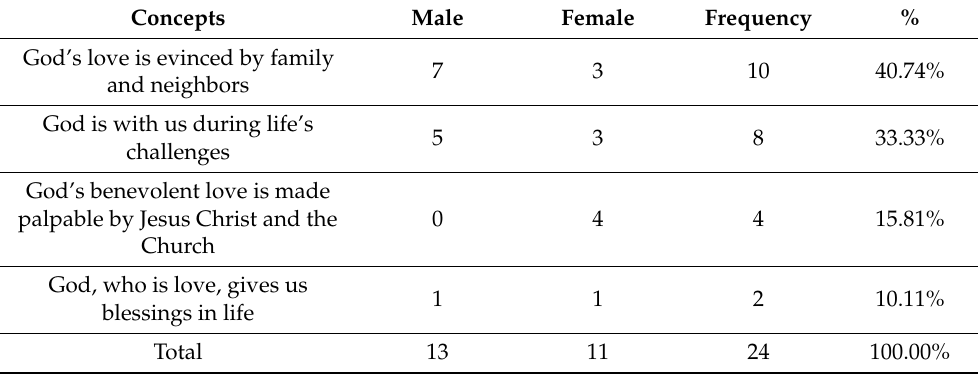
Table 2. Experiences of God’s Love By Select Filipino Christian Youths During the COVID-19